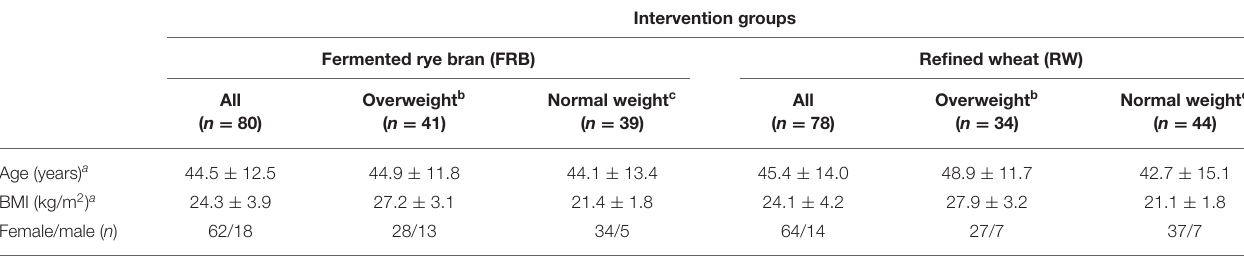
TABLE 2 | Baseline characteristics of the participants who completed the 12-week intervention.